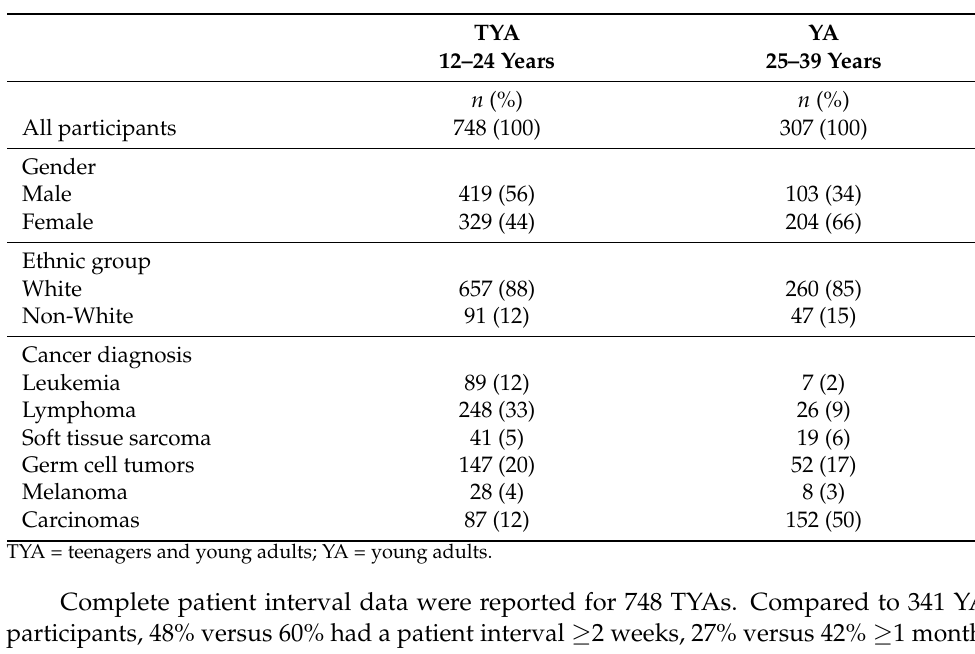
Table 4. Characteristics of TYA and YA population.